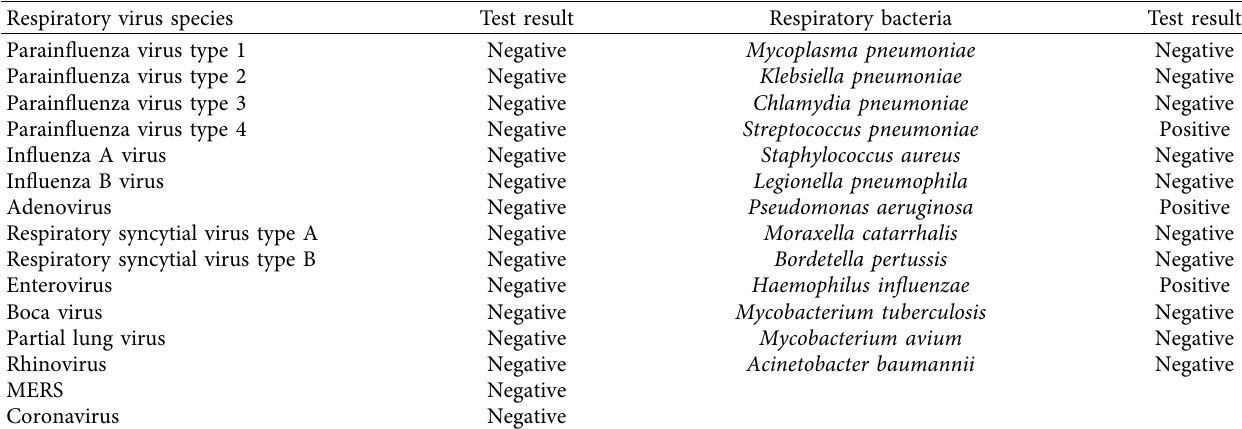
Figure 1: Epidemiological curve of outbreak investigation. Table 3: Common respiratory pathogen test results of the patients’ throat swabs.